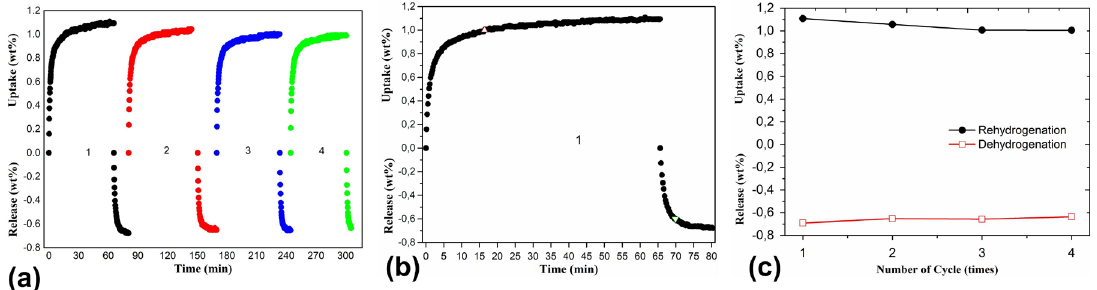
Figure 4. (a) (De)hydrogenation kinetics of the first four cycles, (b) first cycle presented in more detail, and (c) amount of absorbed and released hydrogen as a function of the number of cycles at ambient temperature under 20-bar hydrogen pressure of the cold-rolled TiFe IMC